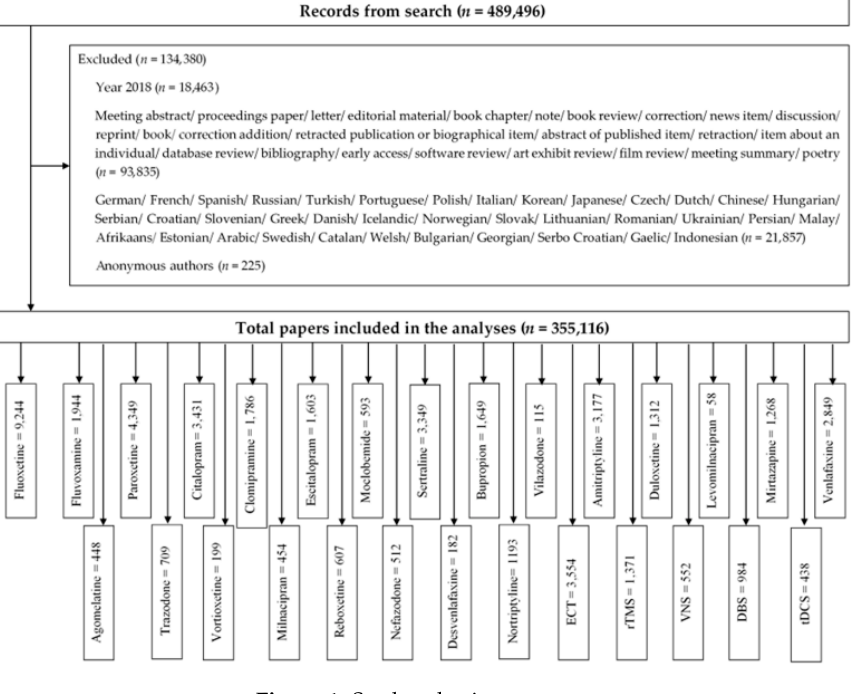
Figure 1. Study selection process.